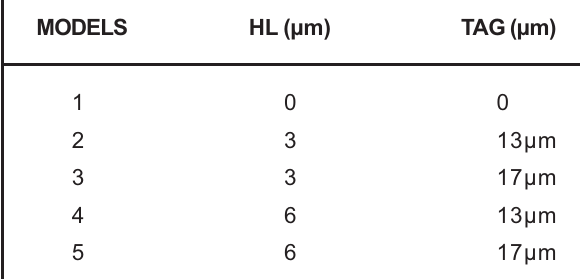
FIGURE 2- Models (1 to 5) with the HL and TAG dimensions (HL – Hybrid layer)